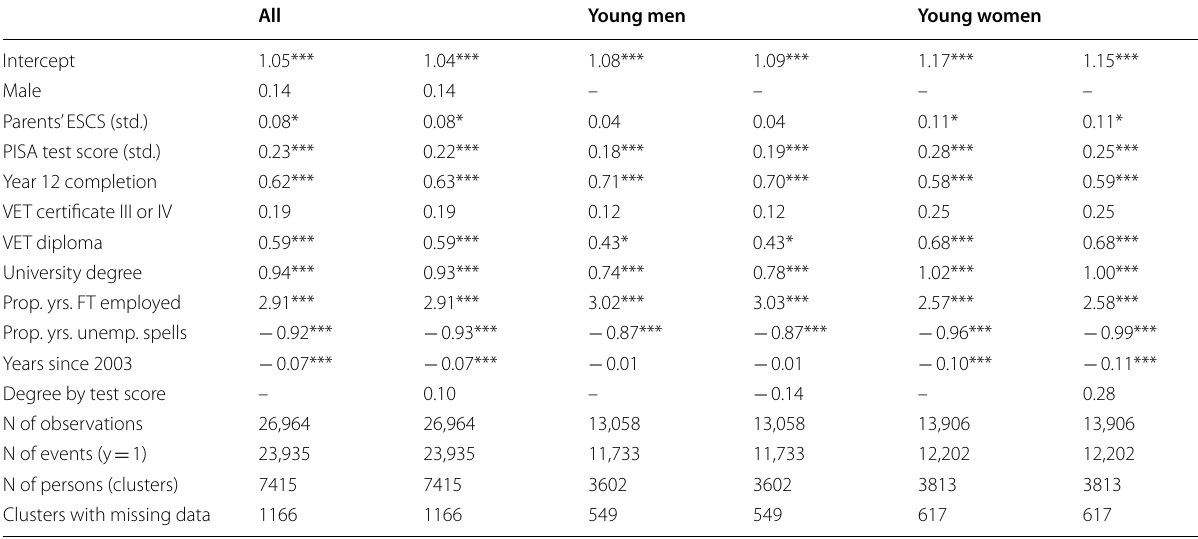
Logit regression coefficients from repeated design analyses. Contrast employed vs not-being-employed. Full-time study observations excluded. Weighted for sample selection and attrition. See Table 1 for